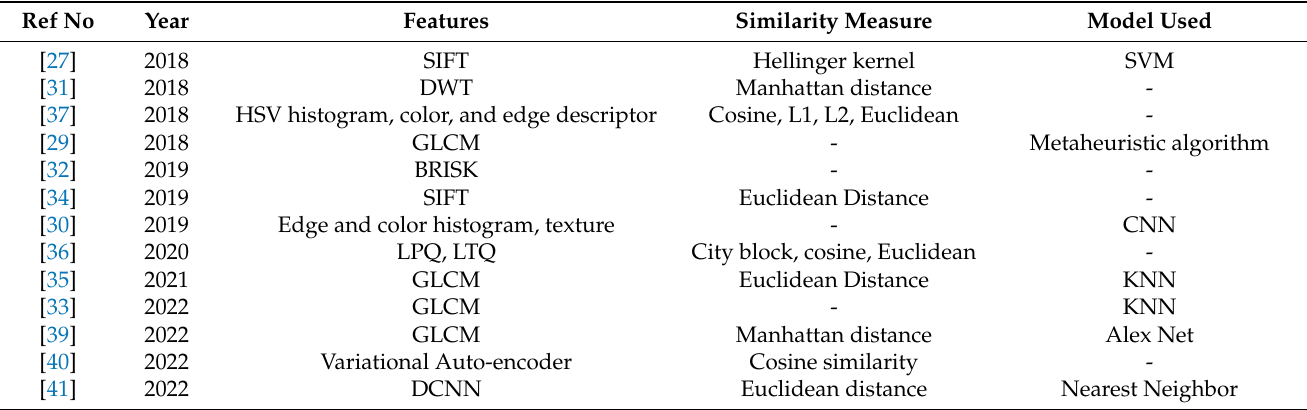
Table 1. Comparison of related